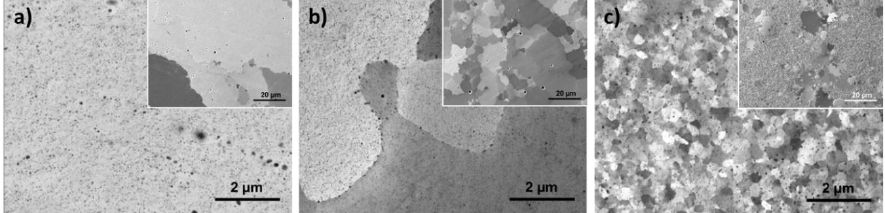
Figure 1. The microstructures of the grades with different Al content in the initial state after heat treatment 16 h/ 1200 °C: ( a ) A1; ( b ) A2; ( c ) A3 with 5.5 wt.%, 2.0 wt.%, 0.3 wt.% of Al, respectively.